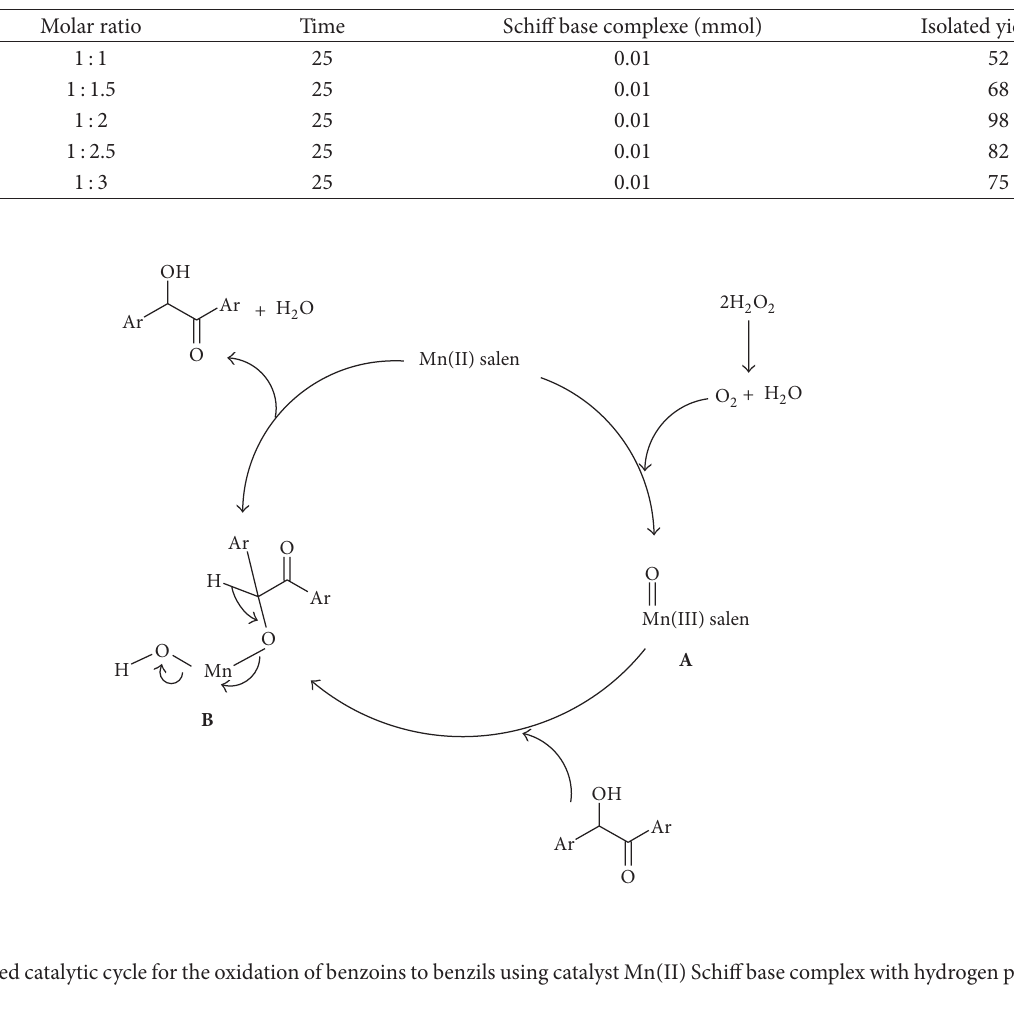
S 3: Proposed catalytic cycle for the oxidation of benzoins to benzils using catalyst Mn(II) Schiff base complex with hydrogen peroxide as an oxidant.